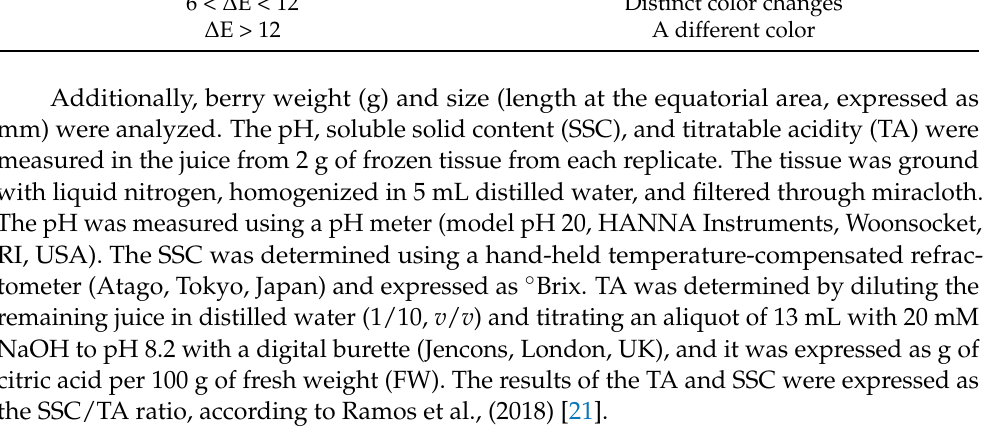
Table 1. Criteria to assess the color change based on Hrˇckov á et al., 2018 [20]. Parameter Description ∆ E < 0.2 Invisible changes 0.2 < ∆ E < 2 Small changes 2 < ∆ E < 3 Color changes visible by high-quality filter 3 < ∆ E < 6 Color changes visible by medium-quality filter 6 < ∆ E < 12 Distinct color changes ∆ E > 12 A different